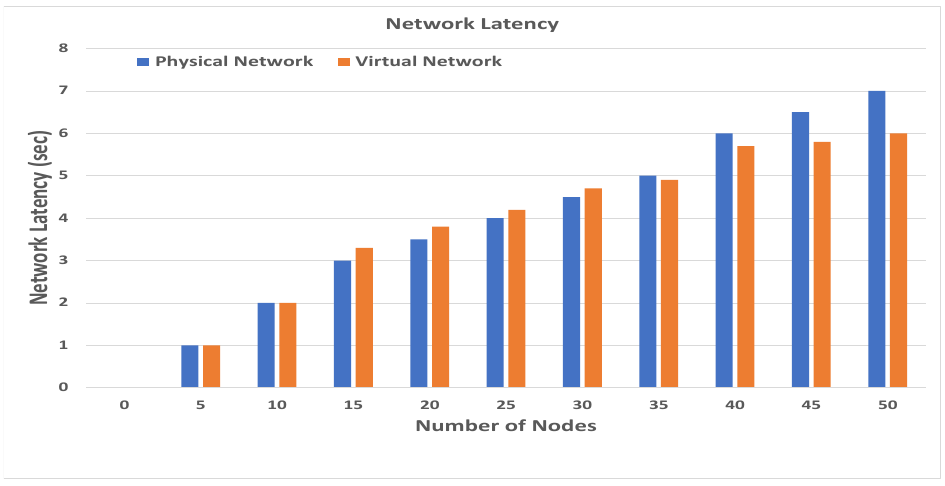
Figure 12. Comparison of network latency between virtual IoT network and physical network.